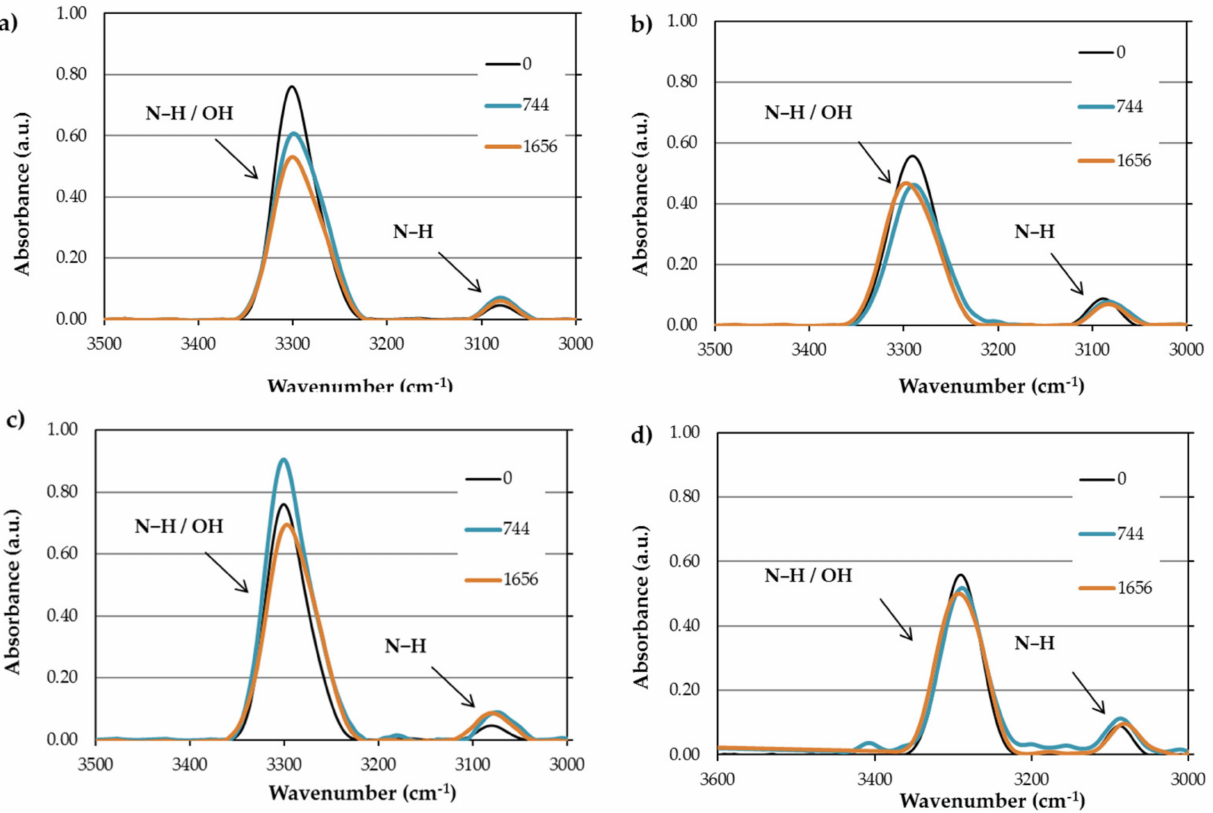
Figure 16. Comparison of OH/NH band between PA11 and PA12 after water and moisture absorption: ( a ) PA11-W; ( b ) PA12-W; ( c ) PA11-RH; ( d )